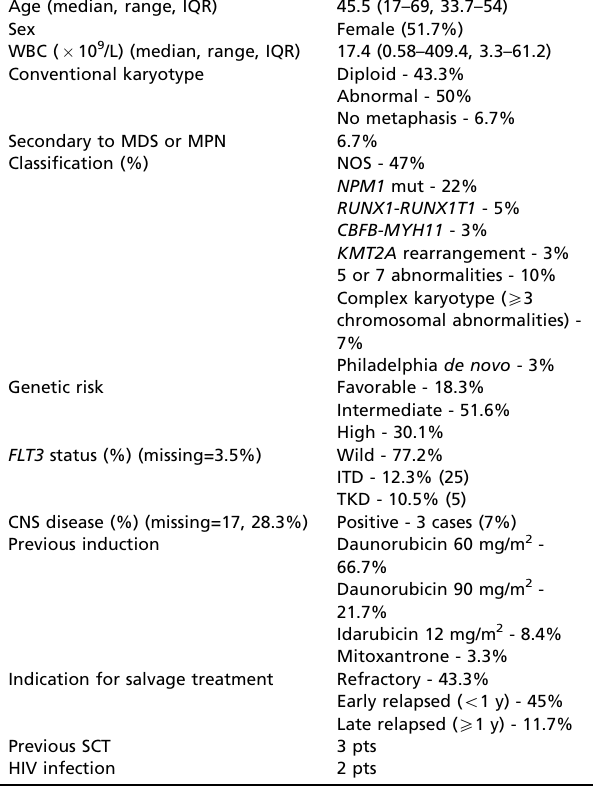
Table 1 - Baseline characteristics of the total cohort (n=60). Age (median, range,